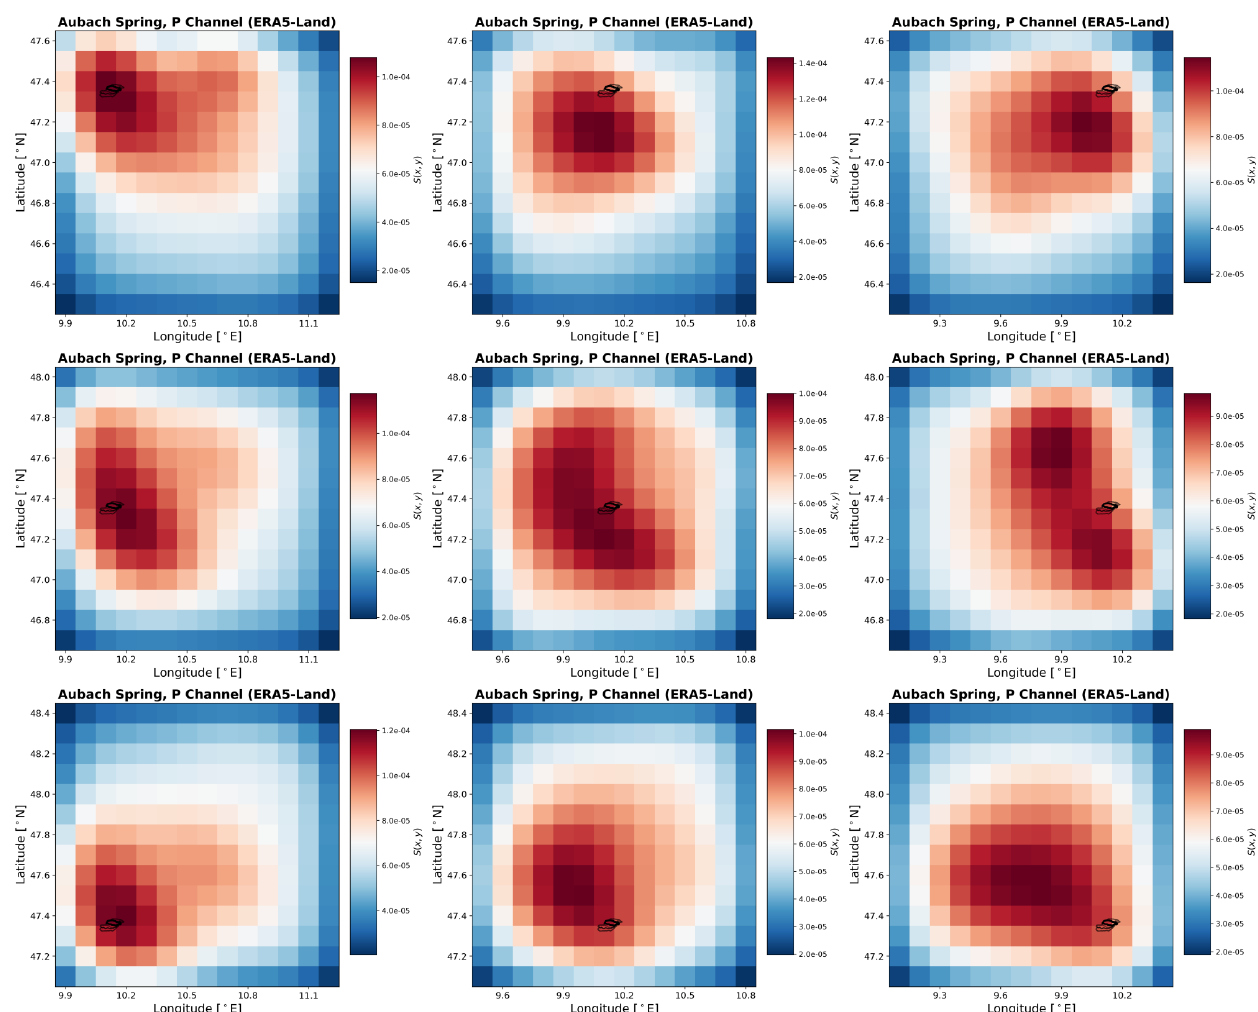
Figure C2. P-channel heat maps based on ERA5-Land gridded data for Aubach spring with shifted area of the spatial input data in relation to the catchment